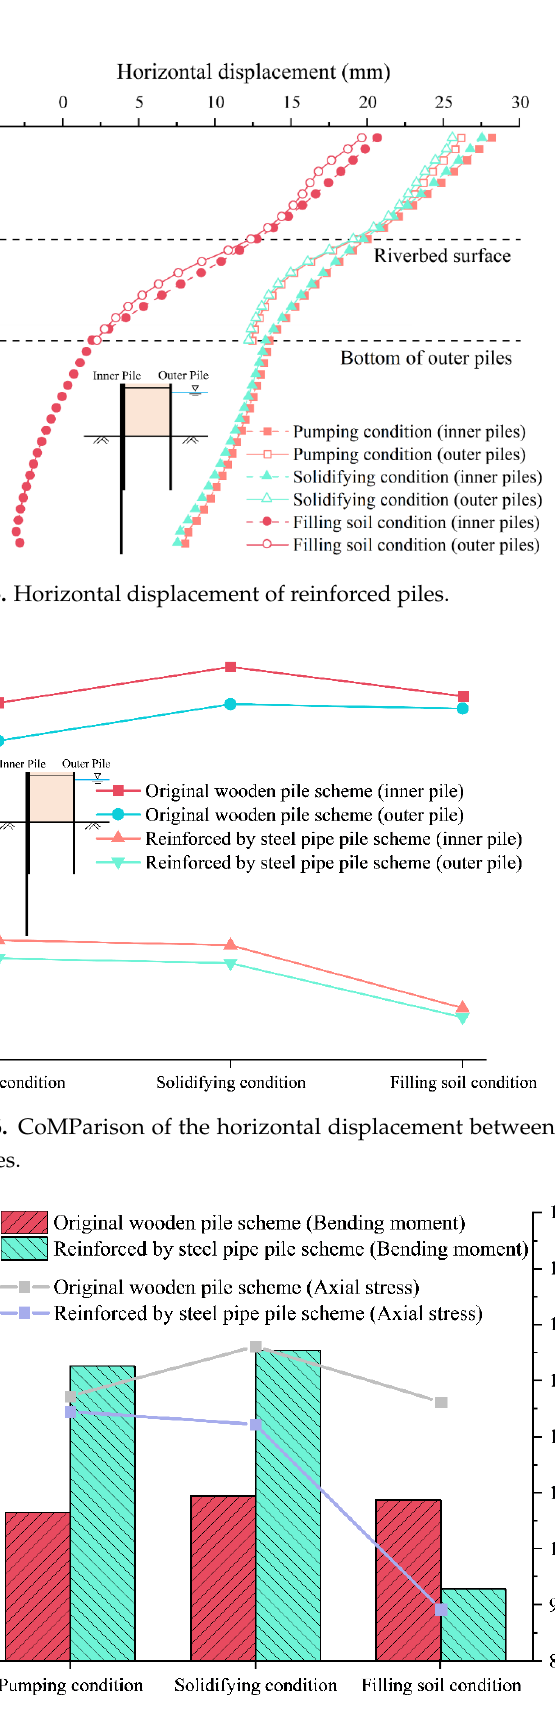
Figure 27. Comparison of the internal force between reinforced piles and double-row wood piles. Figure 27. CoMParison of the internal force between reinforced piles and double-row wood